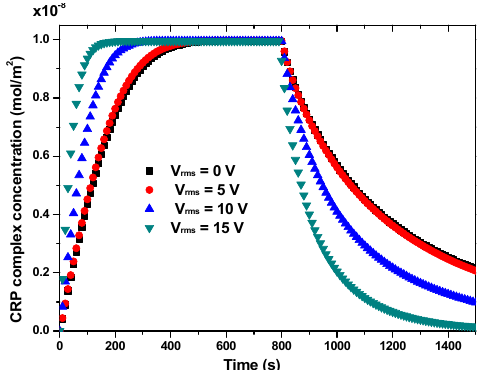
Figure 8. Transient evolution of CRP complex concentration during the association and dissociation phases for several applied voltage V rms from 0 to 15 V and for u ave = 100 μ m/s. The average inlet velocity is fixed at 100 μ m/s.